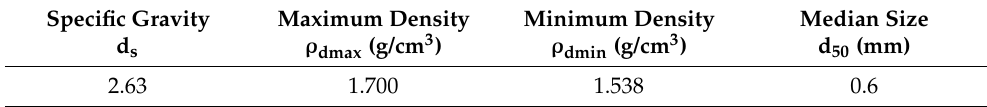
Figure 2. Tested sand specimen after screening. Table 1. Physical parameters of sand specimens.